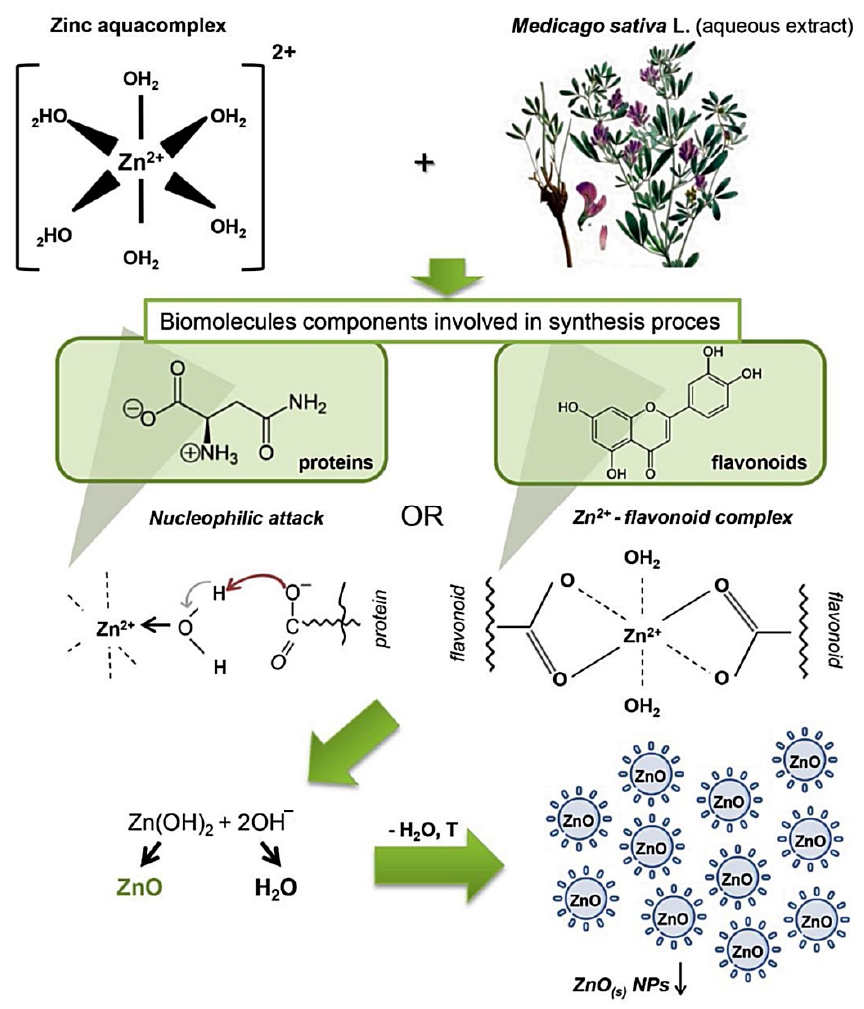
Figure 3. Schematic of the proposed synthesis of ZnO NP using Medicago sativa aqueous extracts. Adapted from [45].